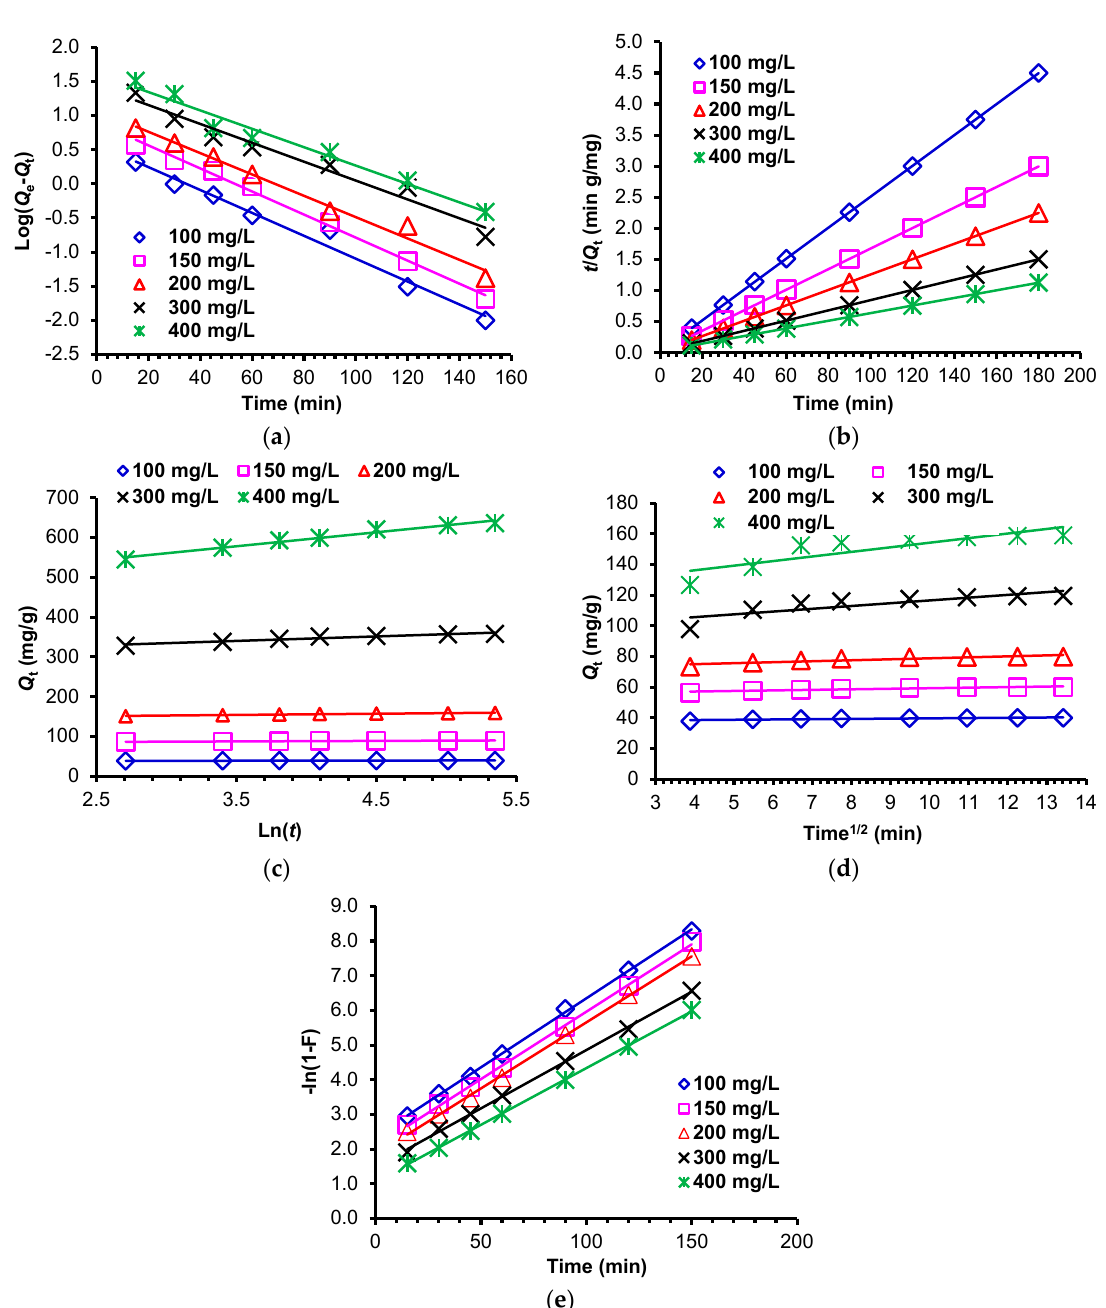
Figure 11. ( a ) Pseudo-first-order kinetic, ( b ) pseudo-second-order kinetic, ( c ) Elovich kinetic, ( d ) intraparticle diffusion, ( e ) film diffusion of adsorption of AO7 dye of initial concentration (100–400 mg/L) by pea pod AC/ZnCl 2– 800 °C under CO 2 dose (2.5 g/L) at 25 ±2 °C.